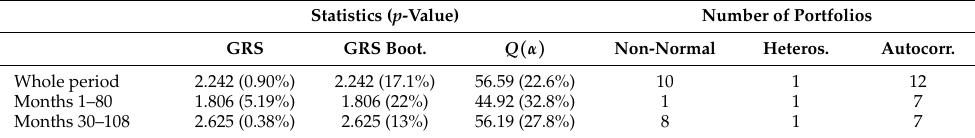
Table 8. Metrics for 5-factors model with different time